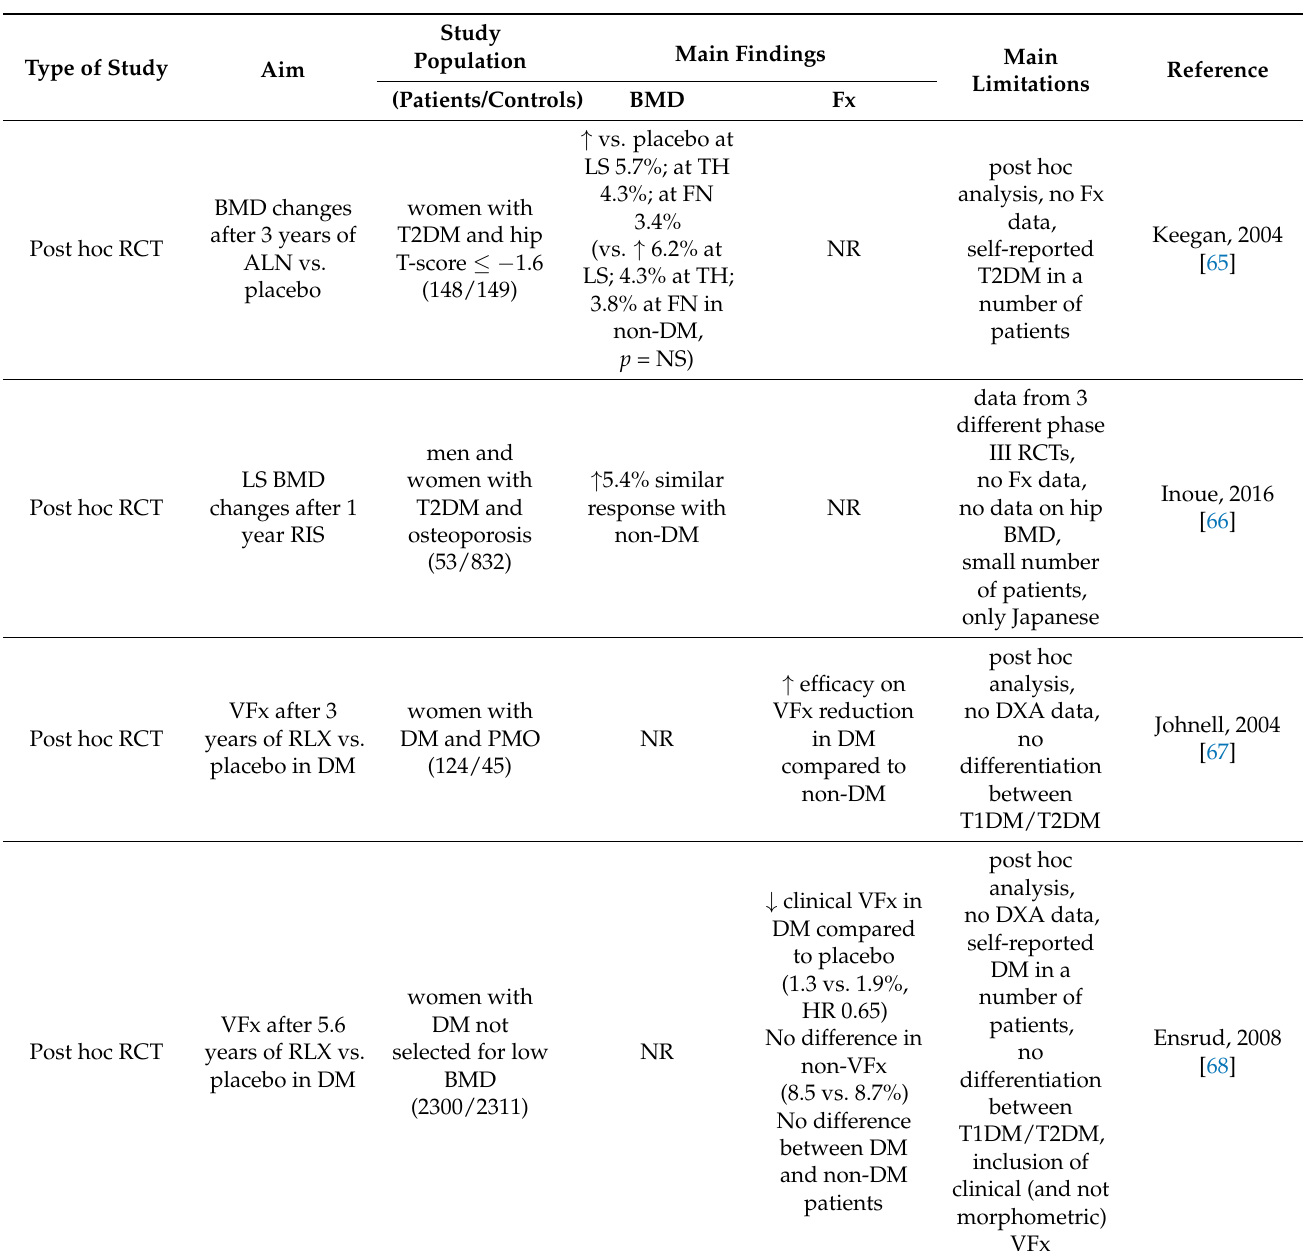
Reference Limitations